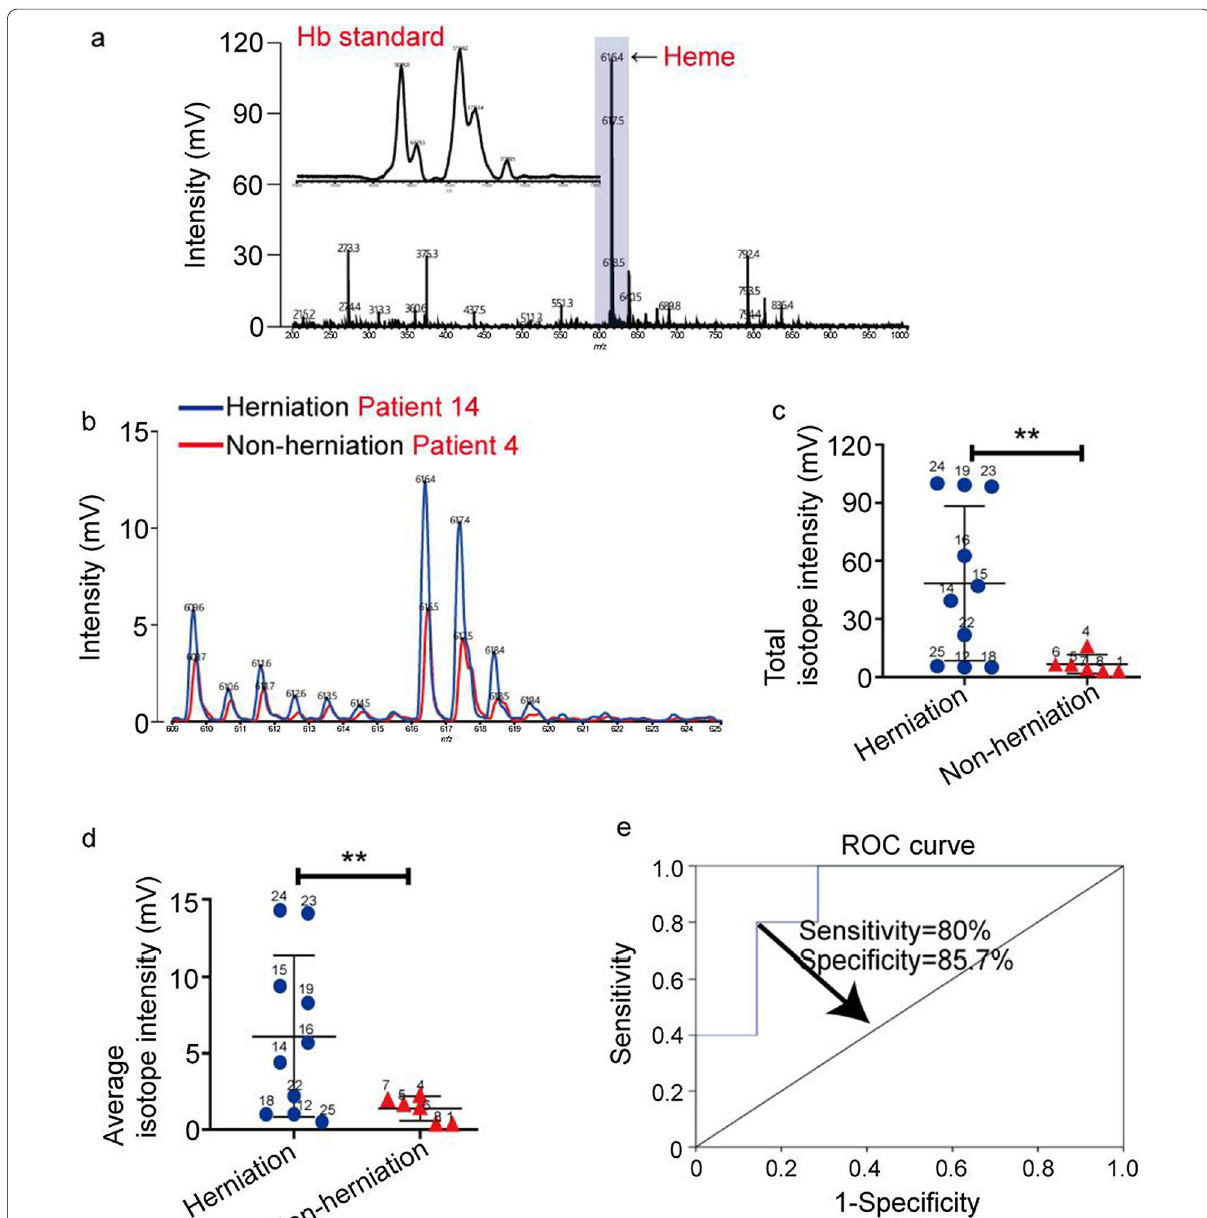
Fig. 2 Specific increase in heme content in herniated nucleus pulposus as analyzed by MALDI-TOF MS. a MS spectra of Hb standard at a low-mass range. b The spectra of tissue lysates from herniated nucleus pulposus and nonherniated nucleus pulposus in the low-mass range. The tissue samples were obtained from the patients 14 and 4 in Table 1. c – d The total intensity ( c ) and average intensity ( d ) of heme and its isotope peaks in 10 samples of herniated nucleus pulposus and 6 samples of nonherniated nucleus pulposus. The data were analyzed with GraphPad Prism